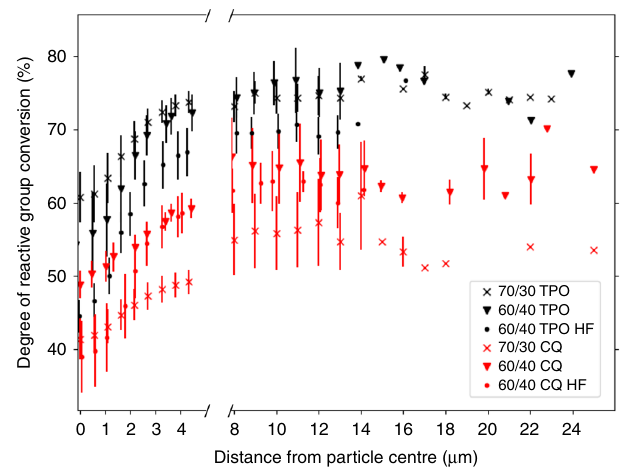
Fig. 2 Inter-particulate variation in reactive group conversion. Degree of reactive group conversion as a function of distance from a fi ller particle centre. Radially averaged conversion (over all particles, centre to edge) is shown to the left of the axis break, while conversion at the midpoint between particle centres is shown to the right side. For both high fi ller (HF) fraction conditions, DC was quanti fi ed at shorter distances compared with other conditions as the particle packing density was higher. Error bars are reported as the standard deviation of radial and inter-particulate measurements. Jitter has been added to for